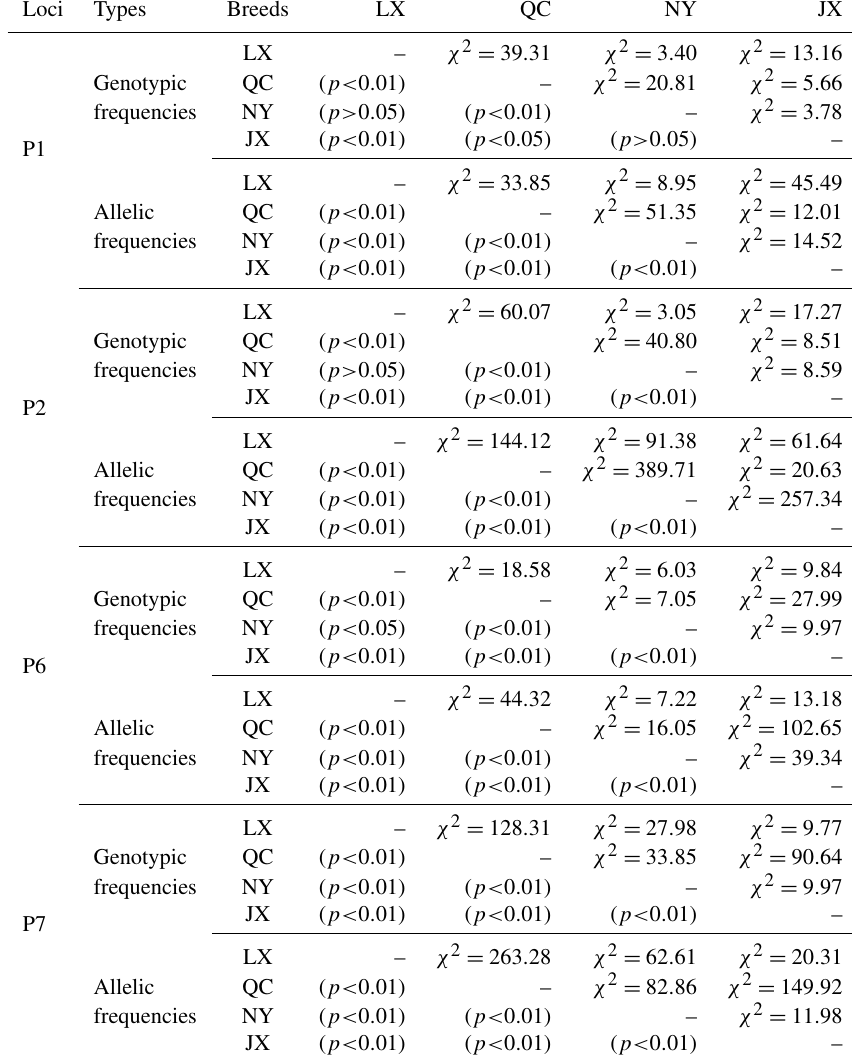
Table 3. The χ 2 test of different breeds on four indels of cattle MSRB3 gene. Loci Types